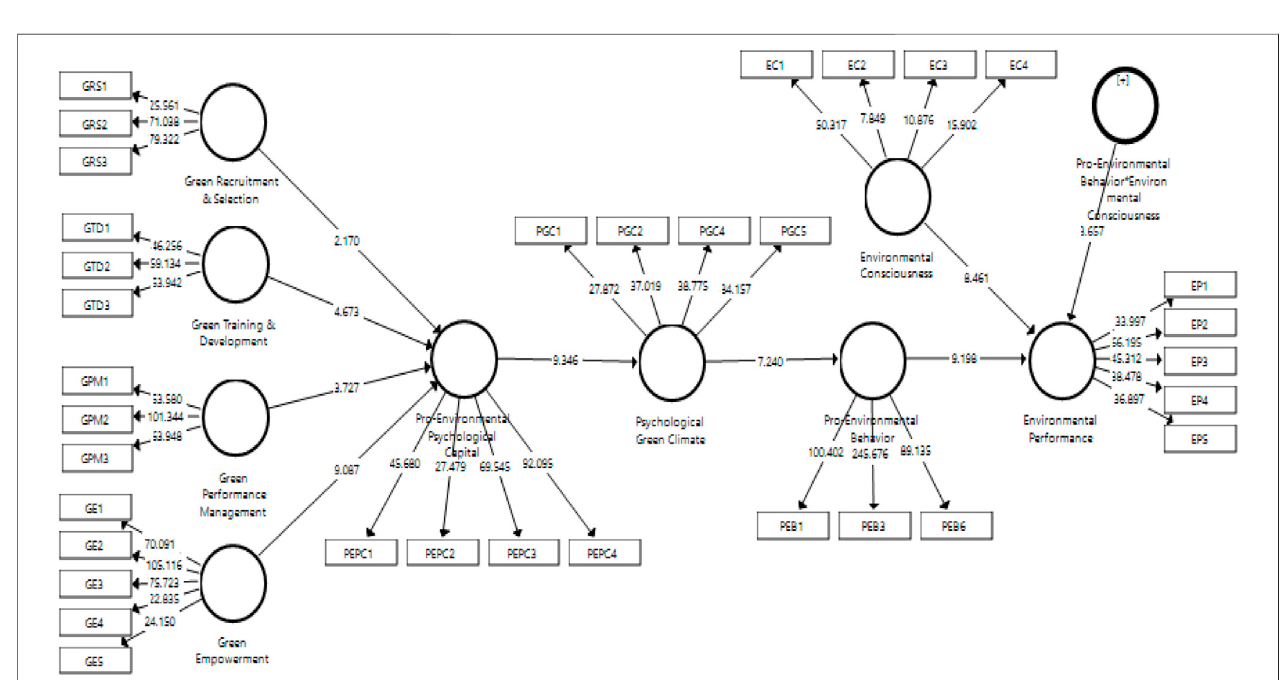
FIGURE 3 | Structural equation